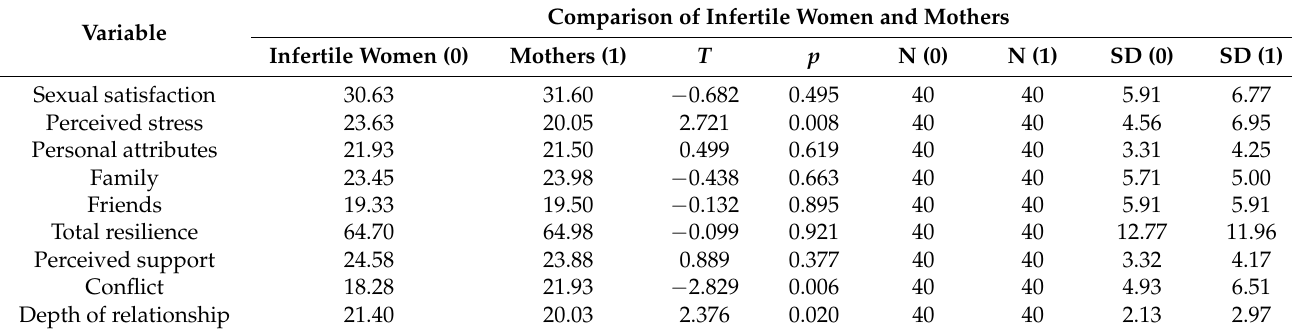
Table 4. Comparison of infertile women and